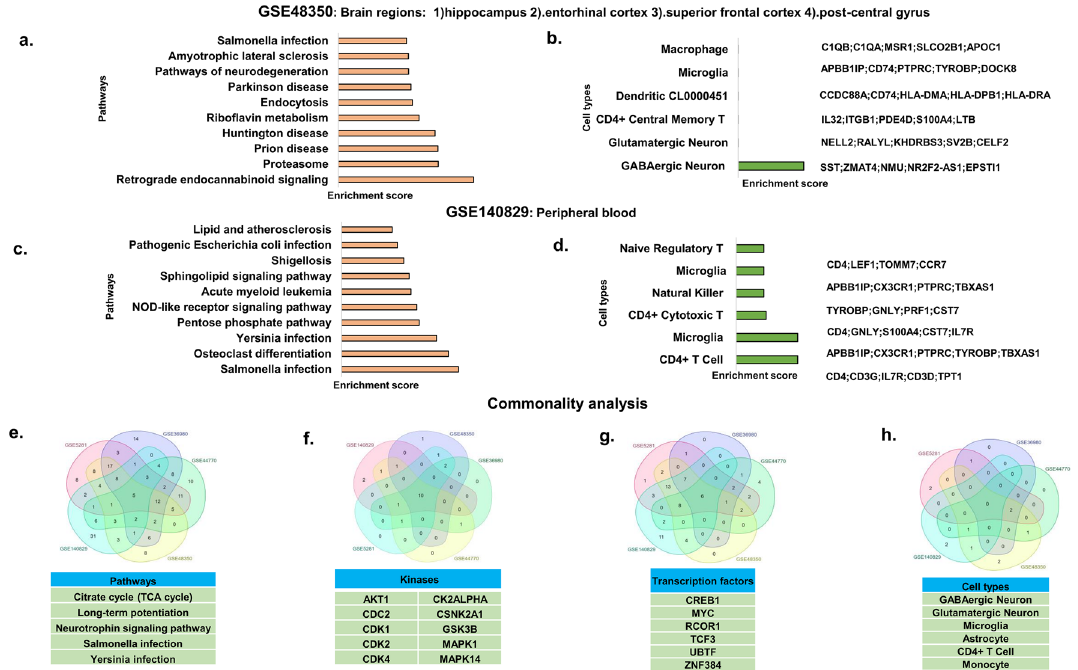
Figure 2. Gene expression data analysis of GSE48350, and GSE140829 GEO datasets. Pathway enrichment analysis of differentially expressed genes by Enrichr tool Top significant pathways from dataset ( a ) . GSE48350 ( c ) . GSE3140829. Cell type analysis and genes associated with each cell type ( b ). GSE48350 ( d ). GSE140829. Commonality analysis for ( e ) . Pathways ( f ). Kinases ( g). Transcription factors ( h ). Cell types. Figure generated using , Microsoft powerpoint 2019 MSO (Version 2212 Build 16.0.15928.20196) 64-bit. Multiple list comparator (https:// molbi otools. com/ listc ompare.